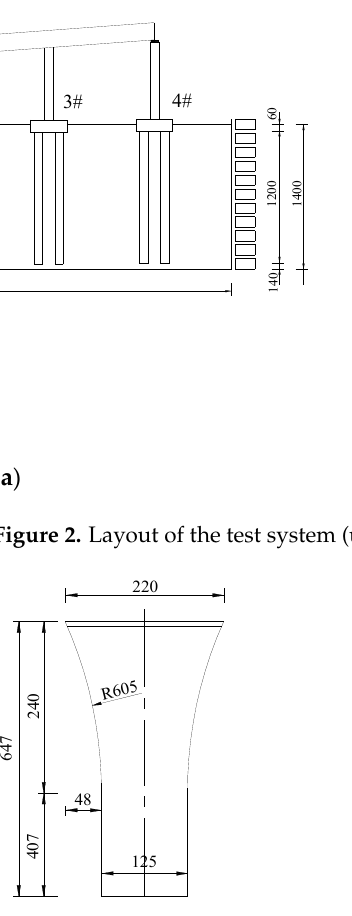
Figure 3. Design of pier 3# (Unit: mm): ( a ) elevation view; ( b ) lateral view.